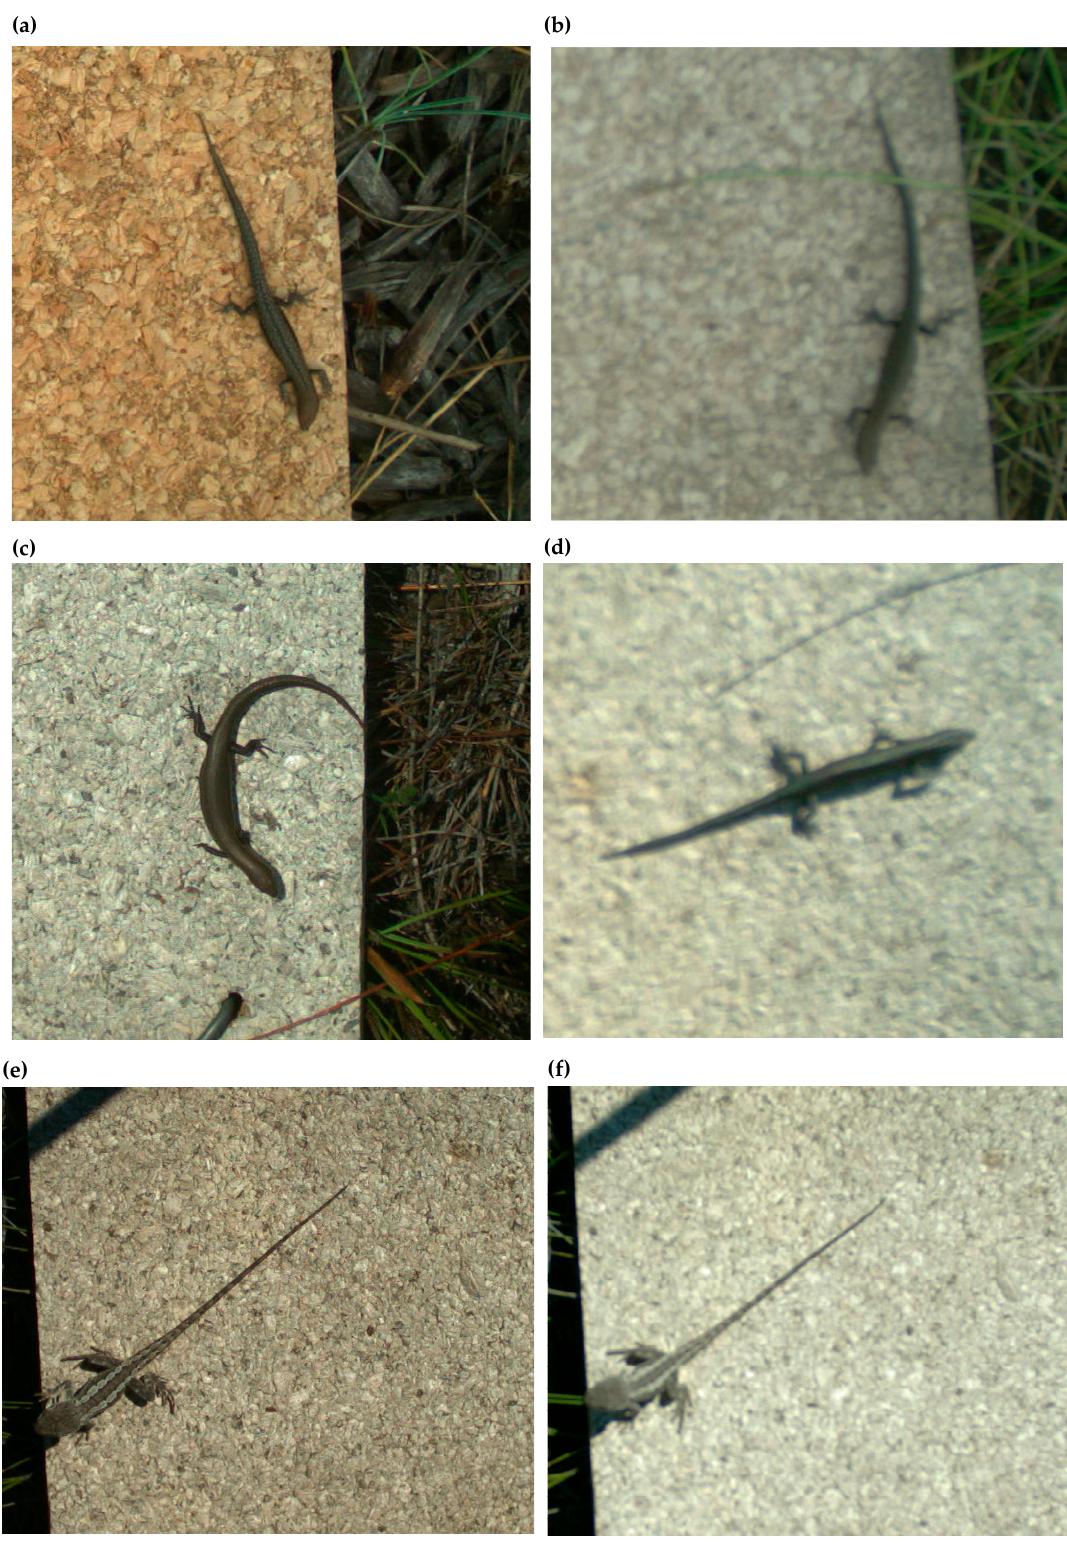
Figure 7. Enlarged sections of images of the same individual grass skink ( Lampropholis guichenoti ) ( a and b ), garden skink ( Lampropholis delicata ) ( c and d ), and jacky dragon ( Amphibolurus muricatus ) ( e and f ). Images (a), (c), and (e) were captured by the modified Reconyx PC900 camera-trap and images (b), (d), and (f) were captured by the standard Reconyx HC600 camera-trap.